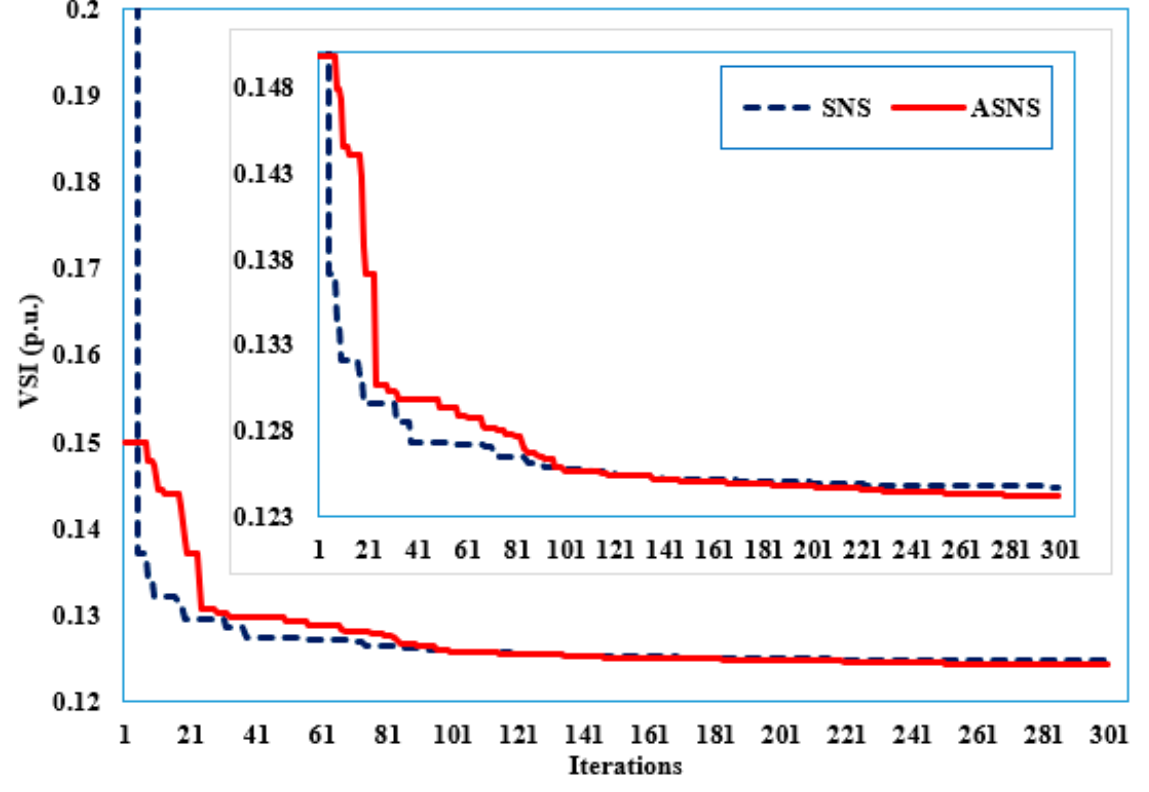
Figure 7. Convergence features of the proposed ASNS and SNS for Case 3 of the IEEE 30-bus grid. Table 6. Results for Cases 1–3 of the IEEE 30-bus grid considering the continuous and discrete nature of tap-changing transformers and shunt